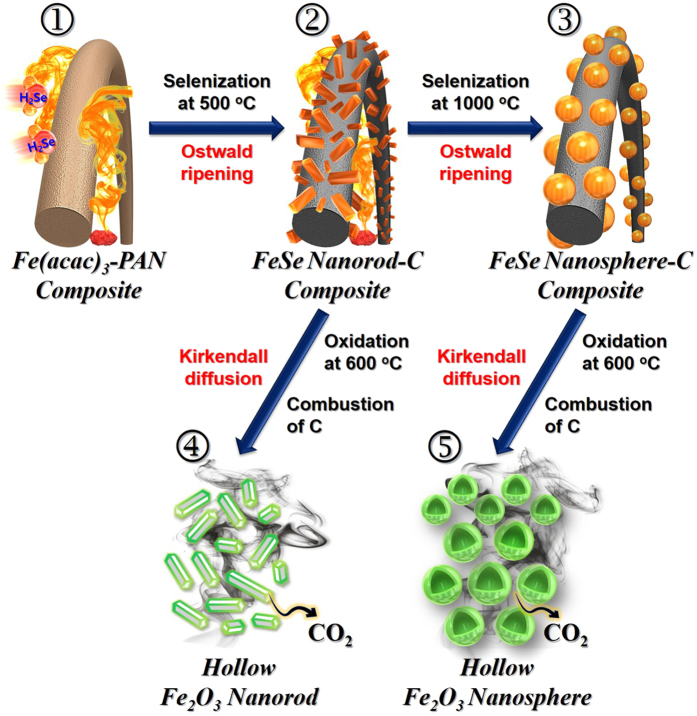
Formation mechanism of the hollow-structured Fe2O3 nanopowders with 0D and 1D structure.